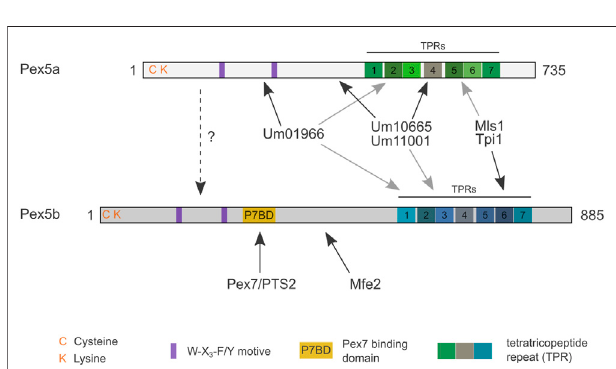
FIGURE7| Modelhighlightingpreferentialcargoofthedifferentdomains of Pex5a and Pex5b. Cargo proteins of different domains are shown. Black arrows point to preferred binding domains. Gray arrows point to secondary binding sites. Please note that the cargo af fi nities of the TPRs are overlapping, while PTS2 import via Pex7 seems to be a speci fi c function of Pex5b. For Mls1 and Tpi1 only speci fi city of the C -terminal dodecamer was determined. If an interaction between Pex5a and Pex5b can occur during import (dashed arrow) or if other functions of Pex5b determine its critical role for Pex5a-dependent import remains to be